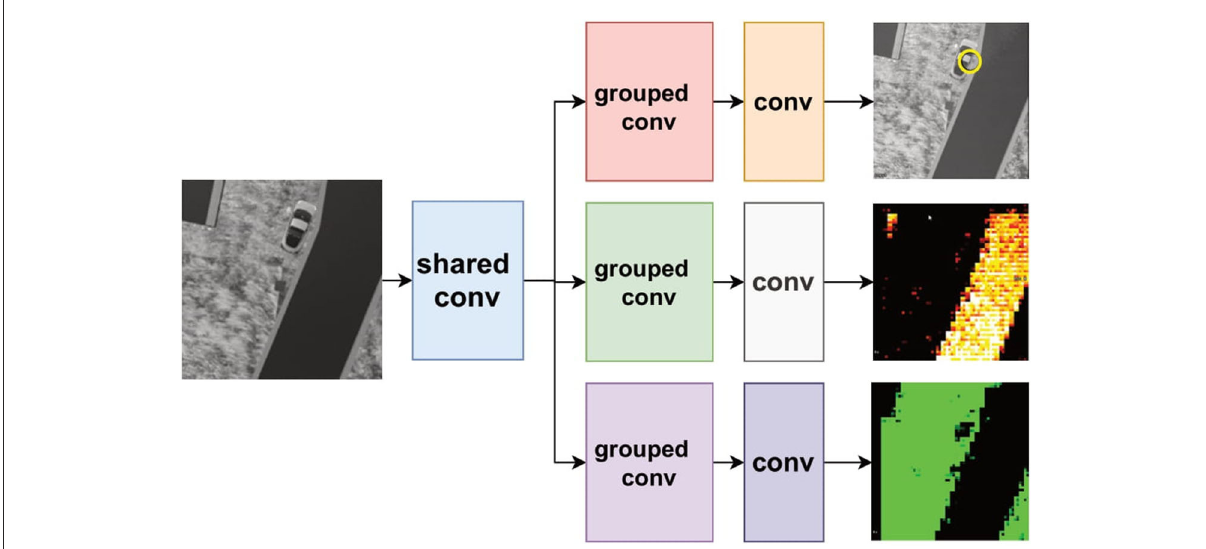
FIGURE15 An FCN tree architecture with a shared convolutional layer for three task-specific FCNs. One of the task-specific FCNs performs object detection (yellow circle), and two of the region segmentation (road and grass).